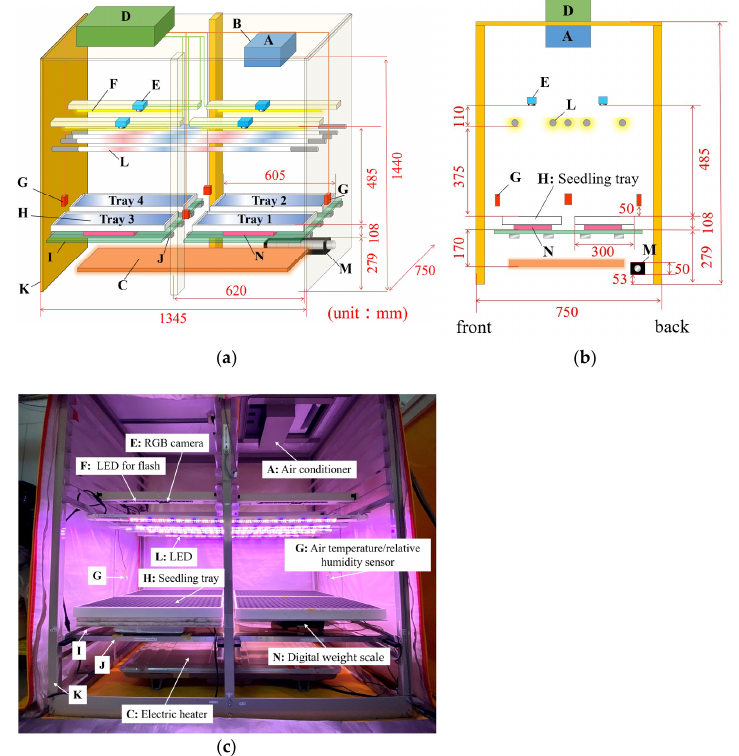
Figure 1. Modular seedling production system (MSPS) equipped with phenotyping unit and air temperature and relative humidity sensors. ( a ) Schematic diagram. (1) Temperature control unit: air conditioner (A), air outlet of the air conditioner (B), electric heater (C). (2) Phenotyping unit: control board ( × 4) (D), red-green-blue (RGB) camera ( × 4) (E), white light-emitting diode (LED) for flash ( × 4) (F). (3) Air temperature and relative humidity sensor ( × 4) (G). (4) Cultivation unit: seedling tray with the substrate (seedling tray) ( × 4) (H), acrylic plate (I), reinforcement bar (J). (5) Exterior box with frame (K). [5] (6) LED (18 W each, length 1170 × width 30 × height 25 mm) (ZK-TB18-VE02/A; Fujian Sanan Sino-Science Photobiotech Co., Ltd., Fujian, China) ( × 5) (L). (7) Air circulator (DC12V 0.2A, blade size: 30 × 190 mm, length 240 × width 48 × height 50 mm) (a15110600ux0249jp; Uxcell, Hong Kong, China) (M), and (8) digital weight scale (linearity error ± 300 mg, precision 100 mg) ( × 3) with data loggers ( × 2) (N). ( b ) Schematic diagram from the side. ( c ) Inside view of